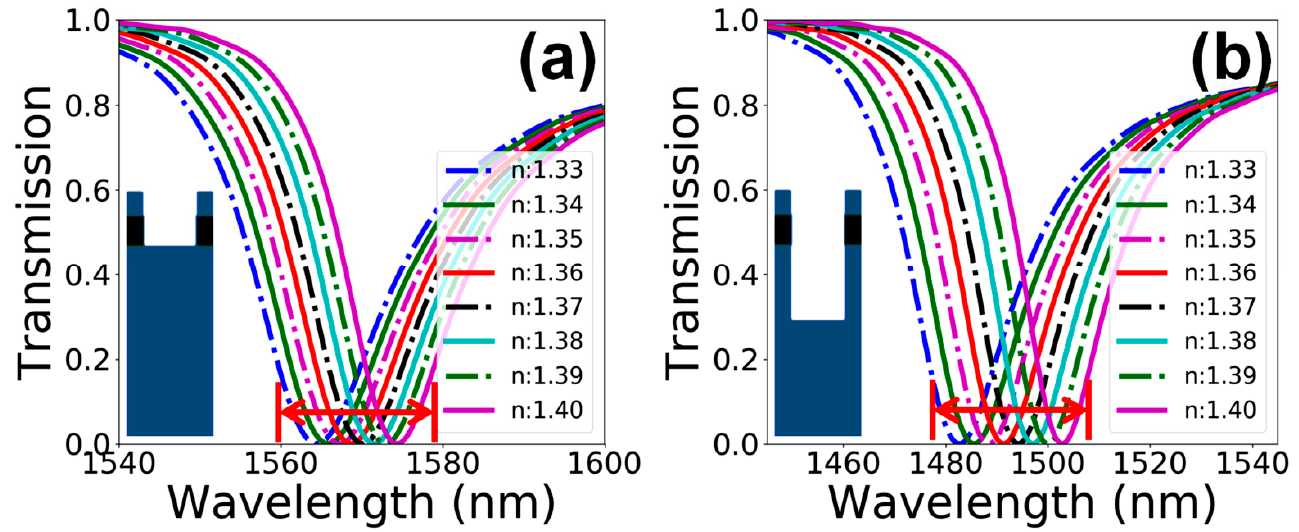
Figure 10. Transmission spectra of a dielectric nanosensor device vs. variation in the ambient refractive index value. ( a ) Hole depth d = 0.63 a . ( b ) Hole depth d = 1.5 a